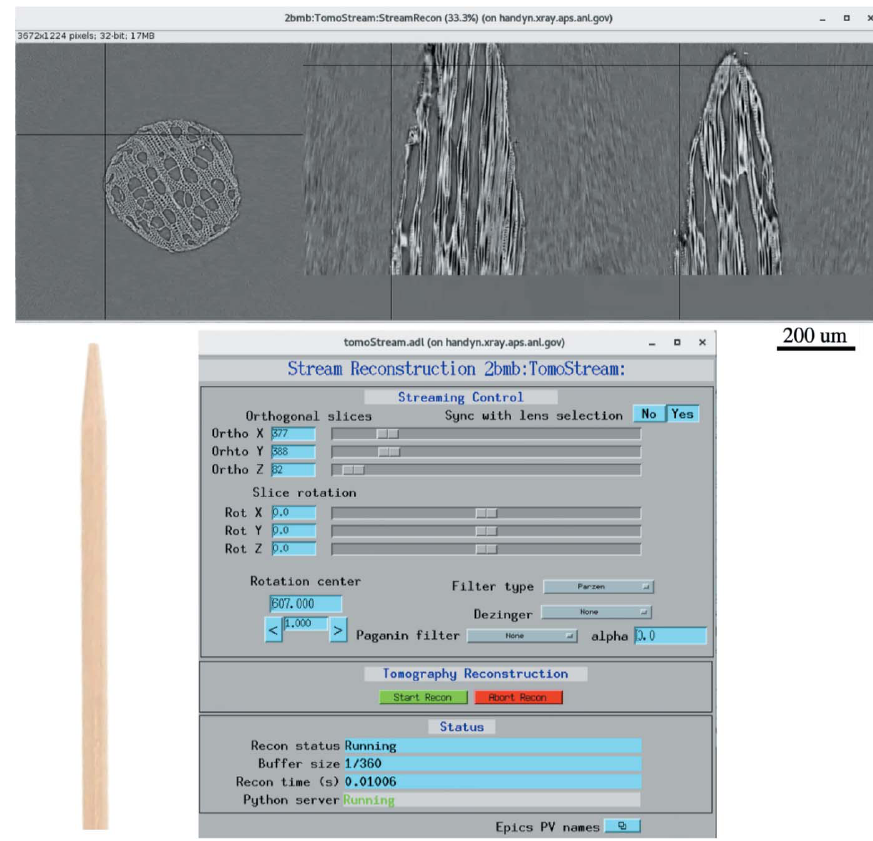
Figure 1 Real-time streaming reconstruction. Top: reconstructed orthogonal slices through a wood stick sample (concatenated as z , y , x ). Bottom: MEDM screen for controlling reconstruction parameters. Solid black lines in the slices visualization indicate positions of orthogonal slices given in the MEDM screen. These slices can be arbitrarily